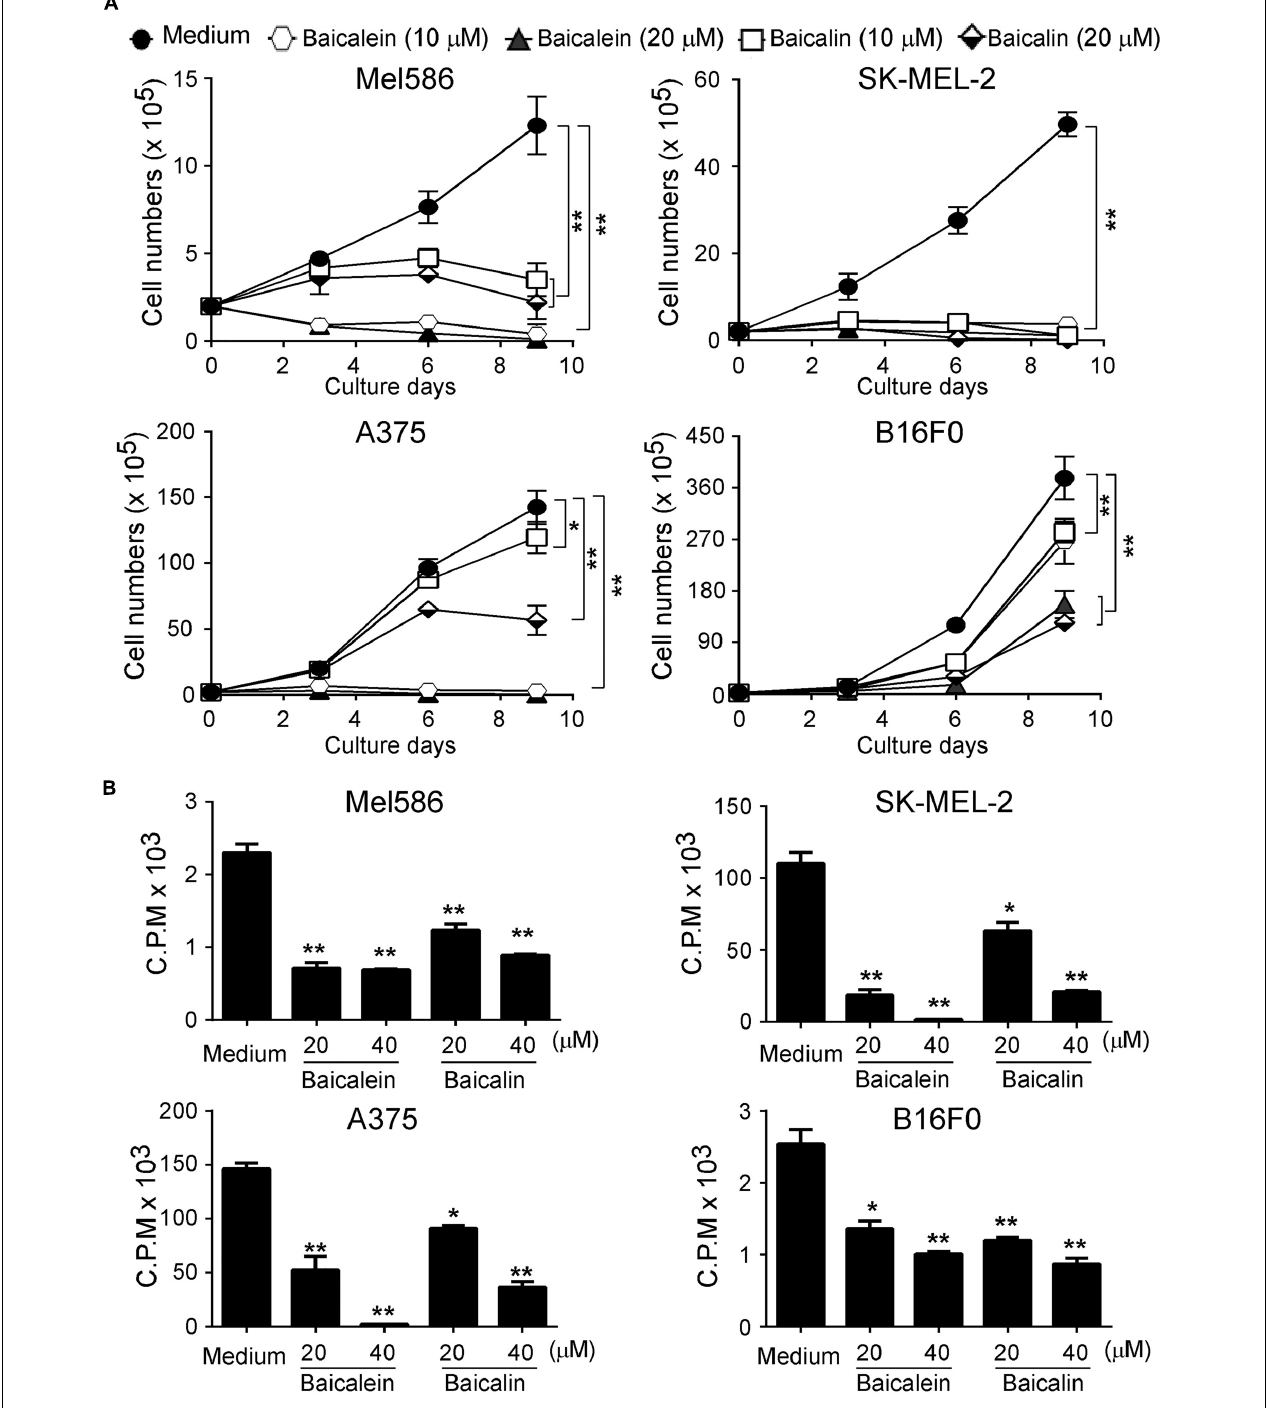
FIGURE 1 | Baicalein and baicalin inhibit both melanoma cell growth and proliferation. Three human melanoma cell lines (Mel586, SK-MEL-2, and A375) and one mouse melanoma cell line (B16F0) were cultured at a started number of 2 × 10 5 /well in 6-well plates, or 5 × 10 3 /well in 96-well plates, and treated with the indicated concentrations of baicalein or baicalin. The cell growth was evaluated at different time points using the cell number counting (A) , and cell proliferation was determined using [ 3 H]-thymidine assays (B) . Data shown in Panels (A,B) are mean ± SD from three independent experiments with similar results. * p < 0.05 and ** p < 0.01 compared with the medium control